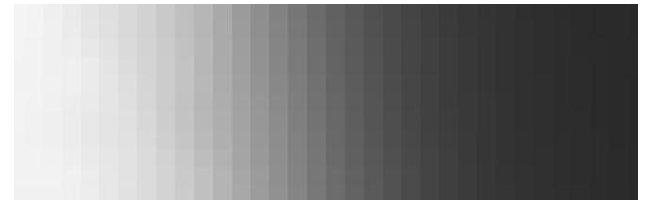
Fig. 7. Image captured from the camera in 10X microscope.